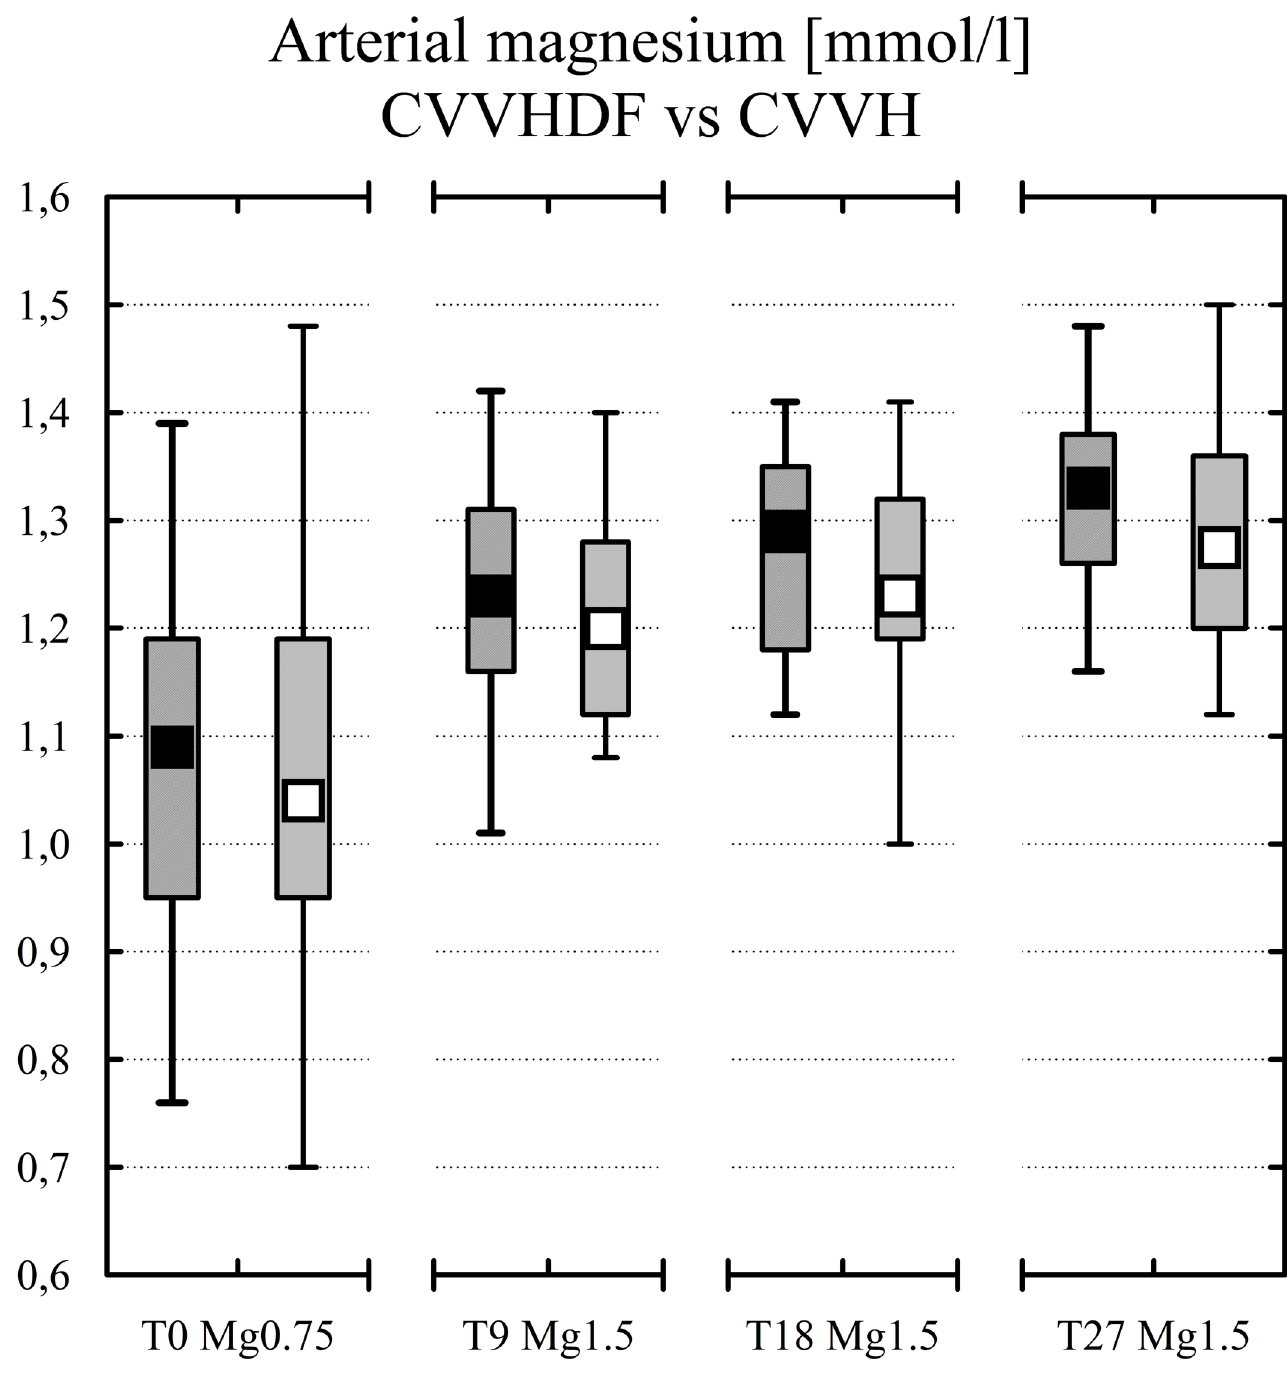
Fig 4. Arterial Mg levels in CVVHDF (black squares), CVVH (white squares) at each study time. Median, IQR in boxes, Min-Max in whiskers.